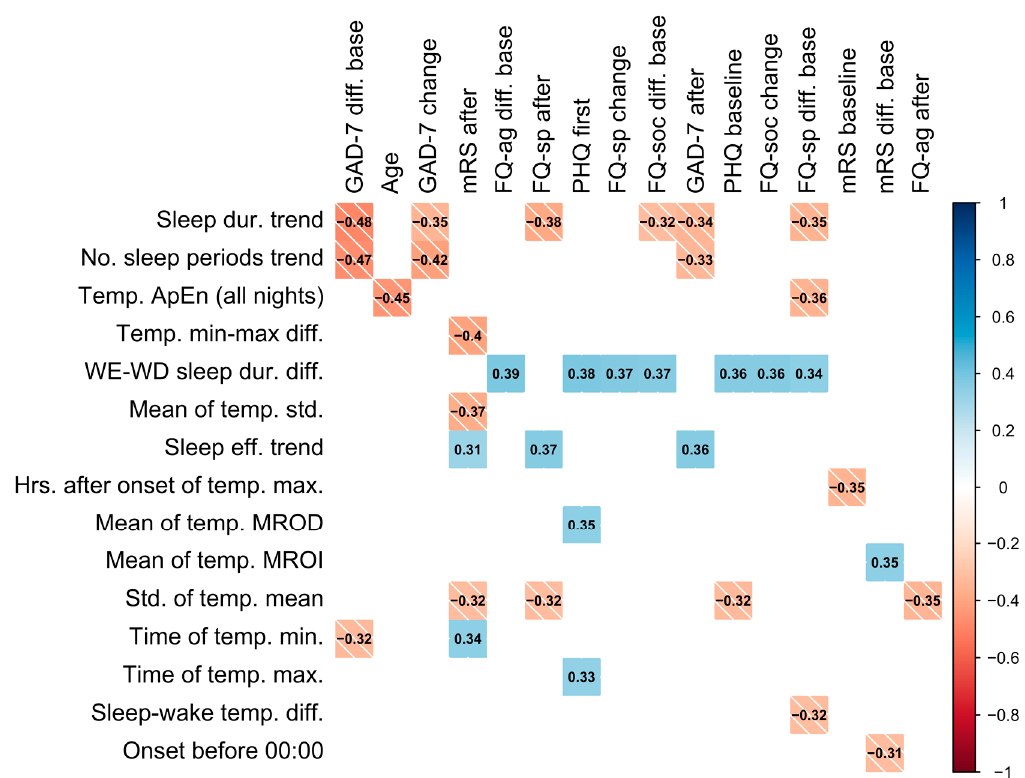
Figure 2. Colored correlation matrix indicating statistically significant ( p < 0.05) Spearman correlations between novel features and questionnaire results, where each variable was computed over a single period of device wear. Only novel features and outcomes with statistically significant correlations are included in the plot. The shade of the square represents the direction of the relationship. “After” denotes the value after a period (of device wear), “change” denotes the change from the previous period, and “diff. base” denotes the change from baseline assessment.